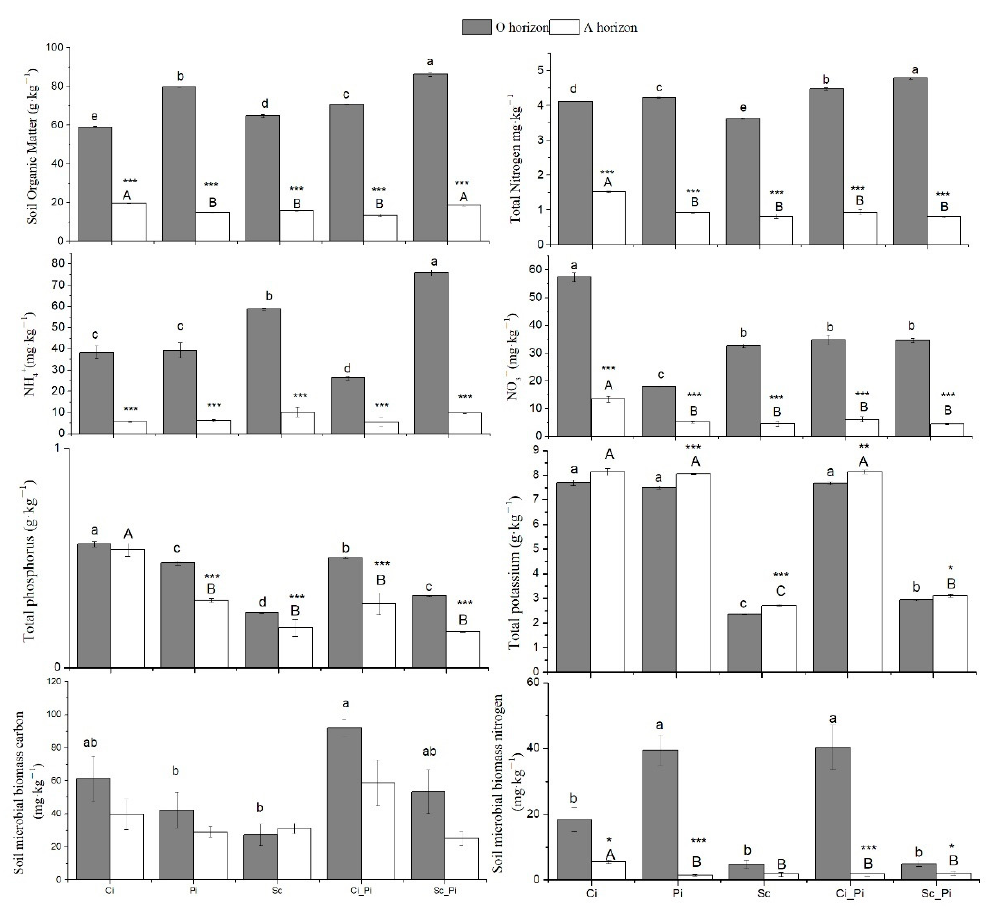
Figure 2. Soil nutrients and microbial biomass in five different forest types. Different lowercase and uppercase letters indicate significant differences among forest types, respectively, for the O horizon and A horizon. ***, ** or * indicate significant differences between the O and A horizon, respectively, at p < 0.001, 0.01, or 0.05.